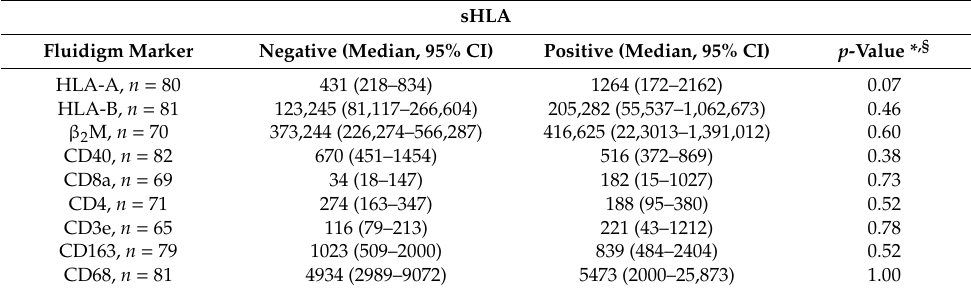
Table 2. Expression of different HLA- and infiltrate-related markers. Presence or absence of soluble HLA (sHLA) in the aqueous humor of UM-containing eyes compared to the expression of HLA and infiltrate related markers as determined by qPCR on primary uveal melanoma-tissue. The median is displayed, with the 95% bootstrap Confidence Intervals (CI).